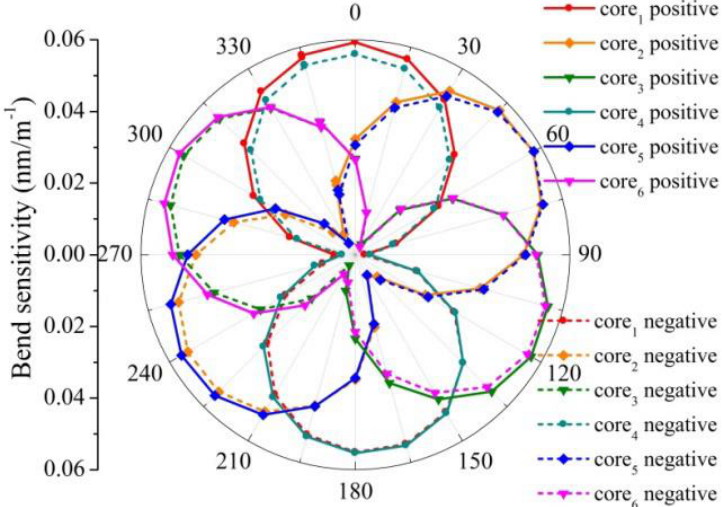
Figure 10. Bend sensitivities for the six outer-core FBGs in the seven-core fiber plotted for various bend directions (from 0 ◦ to 360 ◦ ). Reprinted with permission from Ref. [42] © 2018 Optica Publishing Group.